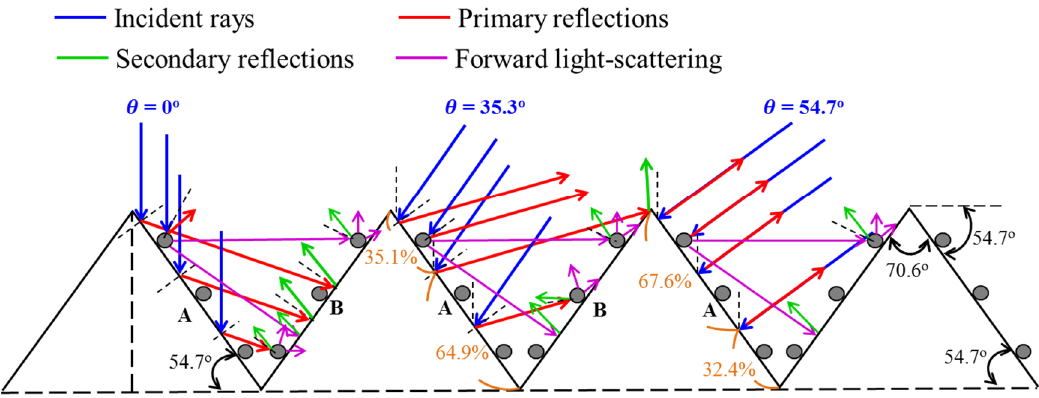
Figure 4. Schematic diagram showing periodic pyramidal-structure coated with In NPs.